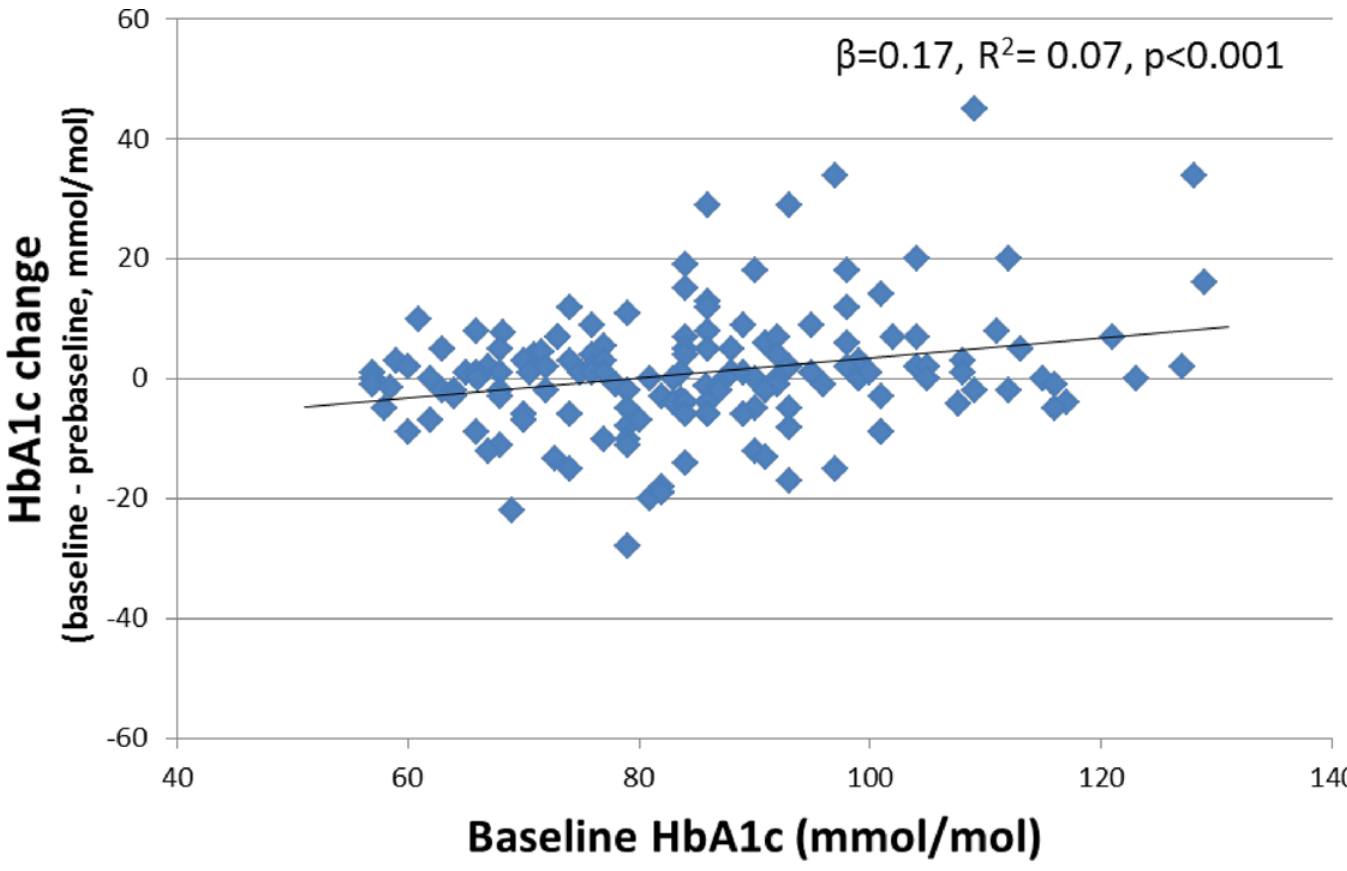
Fig 2. The relationship between baseline HbA1c and change from pre baseline to baseline HbA1c (GLP-1RA cohort). A positive HbA1c change denotes an increase between pre-baseline and baseline measurements. baseline HbA1c with a 1mmol/mol increase in baseline HbA1c associated with an 0.3% greater HbA1c reduction post treatment (R 2 = 0.10, linear regression β = -0.31 (95% CI -0.42, -0.20), p < 0.001). This relationship persists using a separate baseline measurement (linear regression HbA1c change as percentage of baseline on pre-baseline HbA1c (R 2 = 0.05, β = -0.24 (95% CI